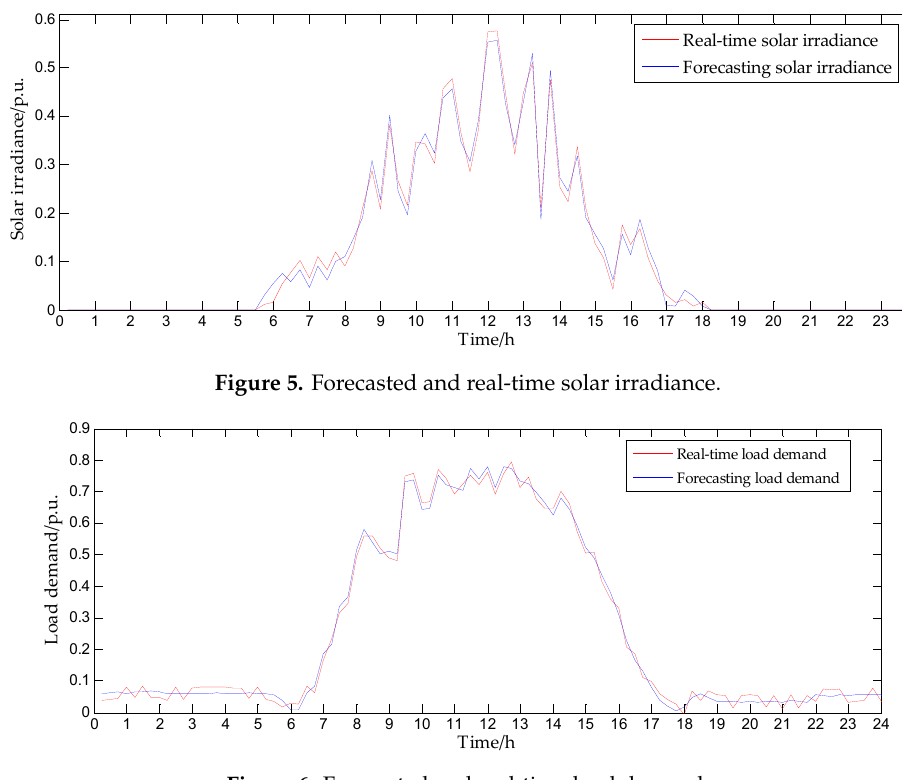
Figure 6. Forecasted and real-time load demand.